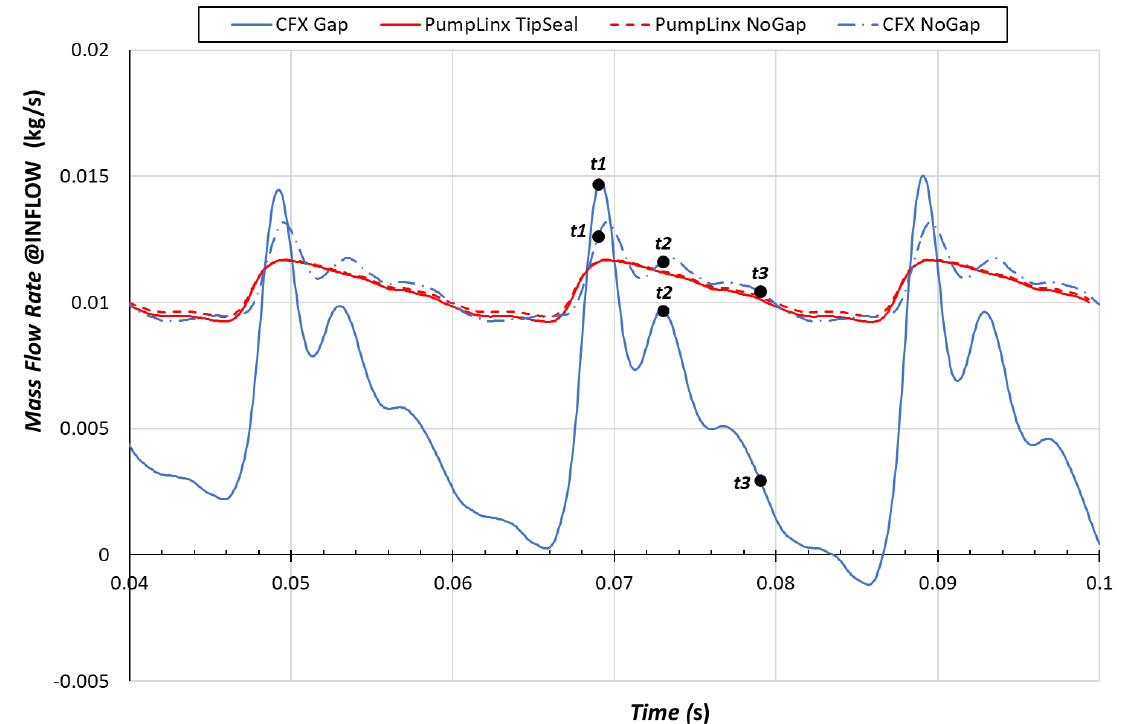
Figure 16. Evolution over time of the mass flow rate at the inlet port during the last three orbit revolutions of the rotating scroll: CFX with axial gap (blue solid line), CFX without axial gap (blue dash-dot line), PumpLinx with the perfect tip seal (red solid line), and PumpLinx without axial gap (red dash-dot line).